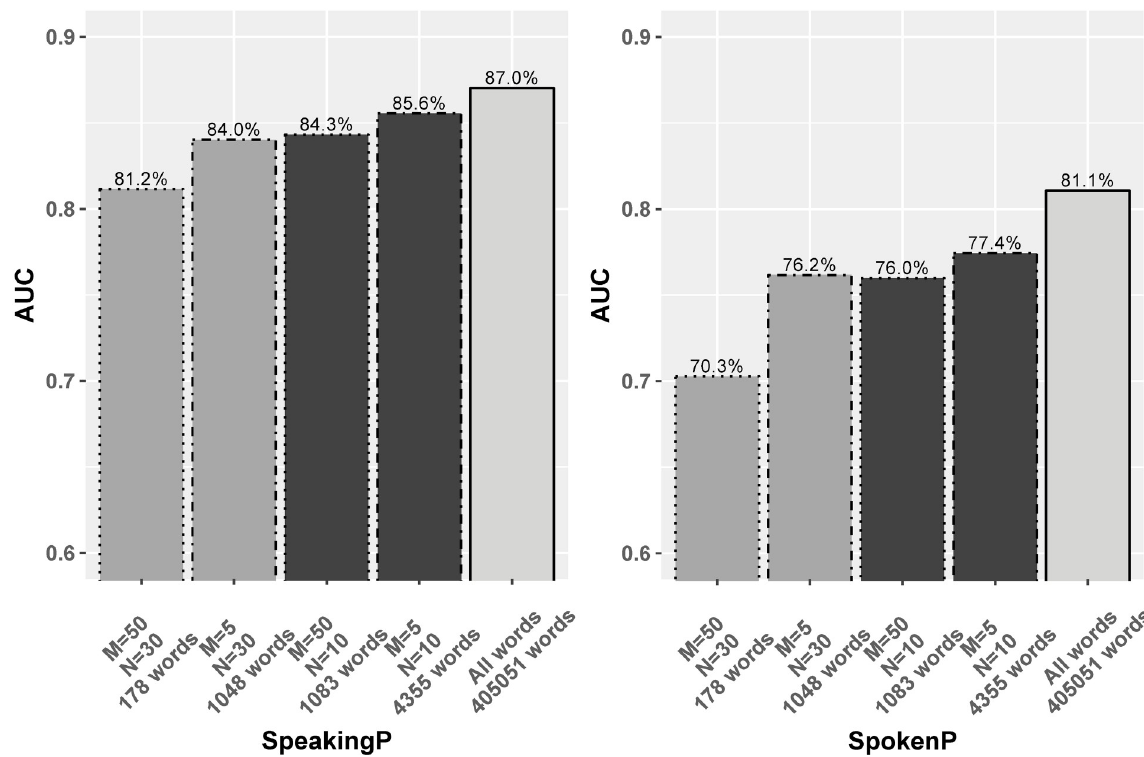
Fig 6. The LMs AUC performance on word sets occurring at least M times in at least N projects in the full dataset.